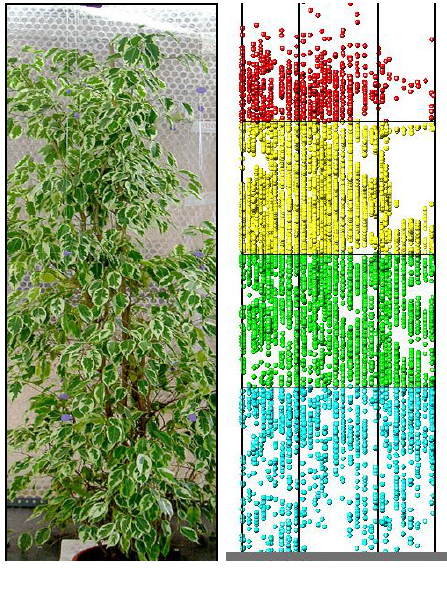
Figure 18. Front view photograph of the Ficus and, also taken from the front, view of the point cloud obtained after combining the front view (F-05A-05S) and rear view (R-05A-05S) scans obtained with the LIDAR